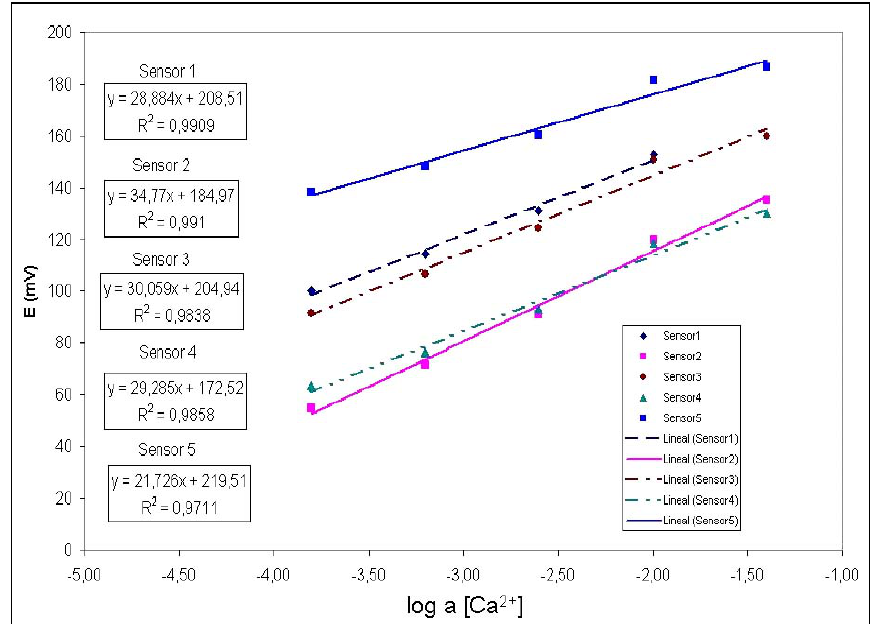
Figure 6. Example of an automated calibration run versus a single ion.